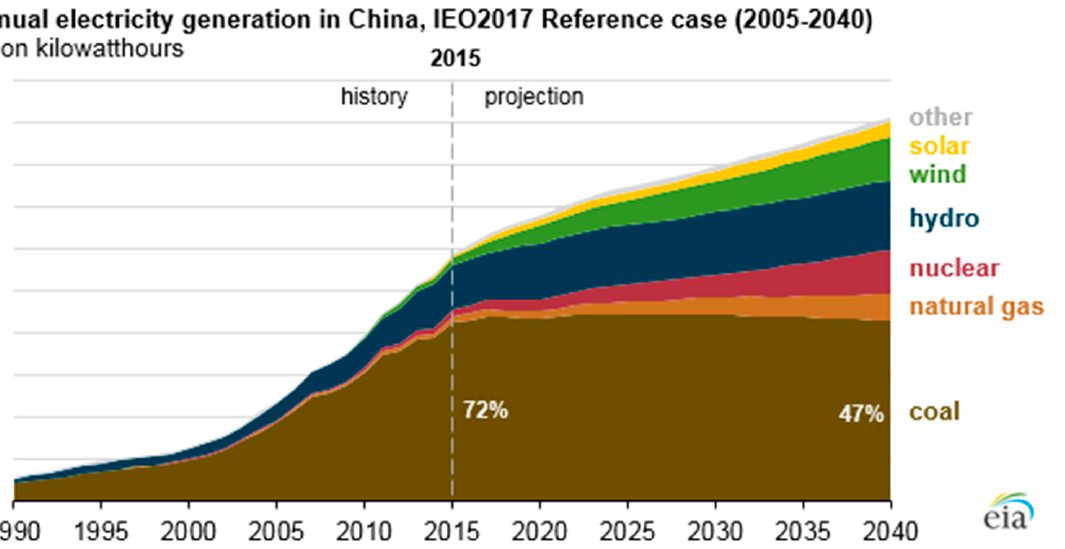
Figure 5. Total capacity in China from 2000 to 2050 (historical data and forecast).